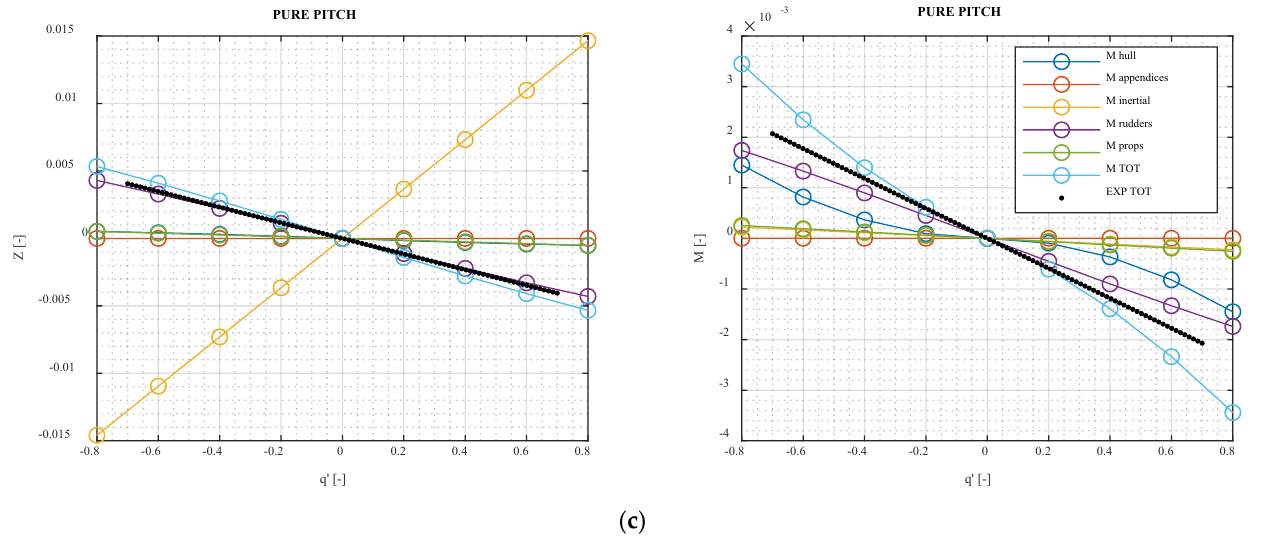
Figure 10. ( a ) DARPA captive model testing validation—horizontal plane. ( b ) DARPA captive model testing validation—horizontal plane roll. ( c ) DARPA captive model testing validation—vertical plane.